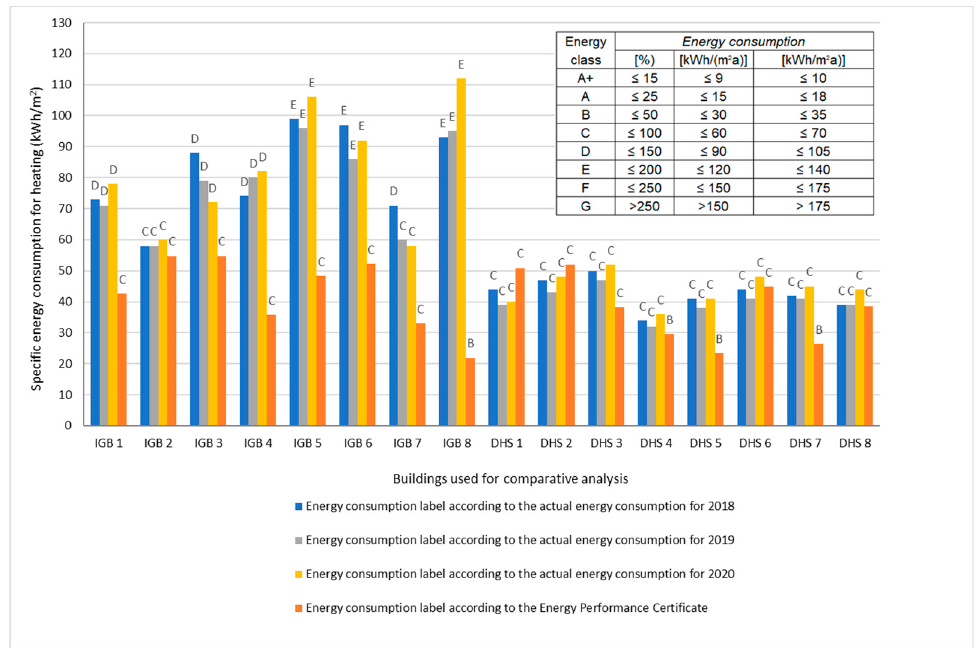
Figure 7. Comparative representation of actual energy consumption label and energy consumption label from EPC for IGB systems and DHS.